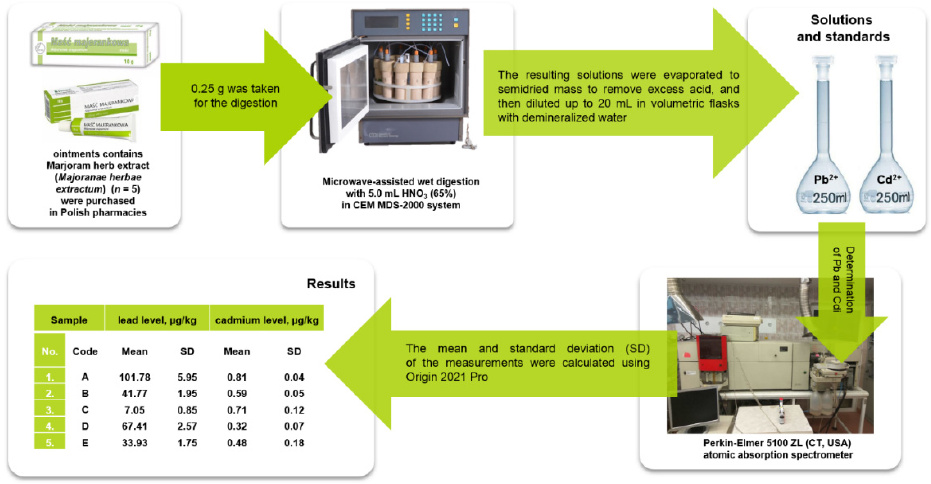
Figure 1. The toxicological analysis concept presented as a workflow diagram.